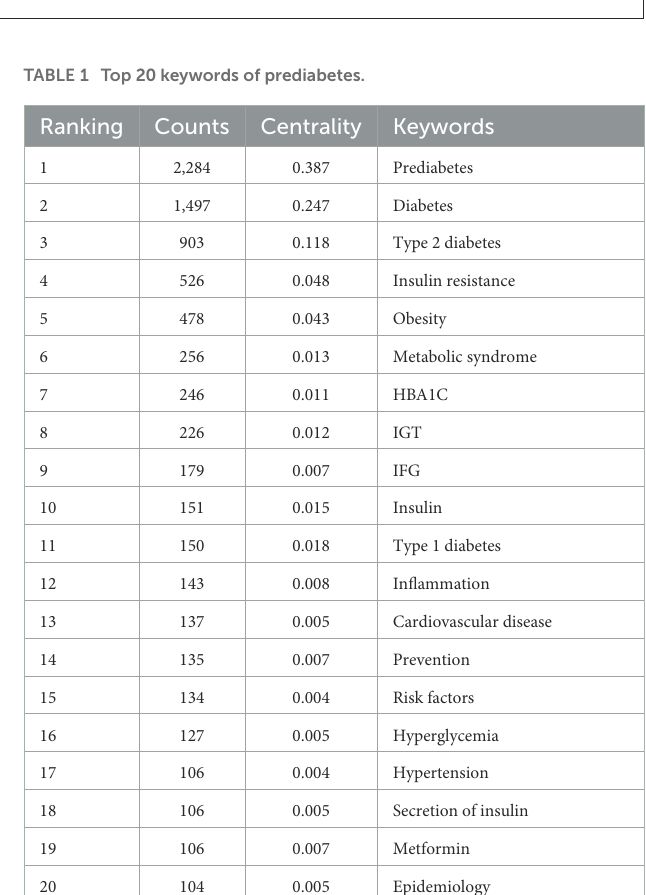
FIGURE3 Number of publications in different countries and their growth trends.